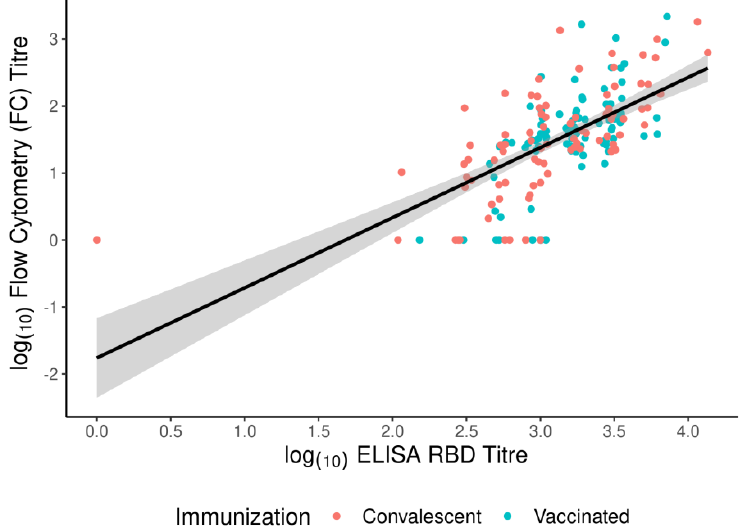
Figure 8. Log10 transformed values of titres obtained from ELISA RBD and FC. Different colour points indicate convalescent (red) and vaccinated (blue) participants. The best-fit linear regression line with a corresponding confidence interval is presented as a black line with a grey band.